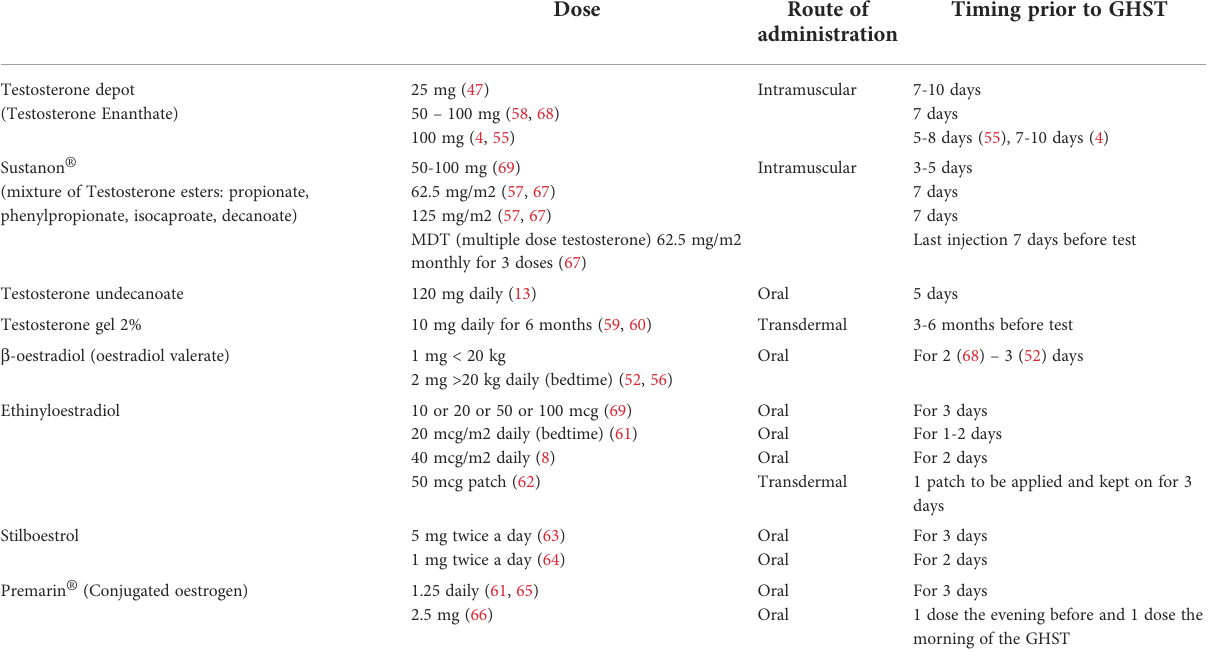
TABLE 3 Sex steroid priming regimens for boys.